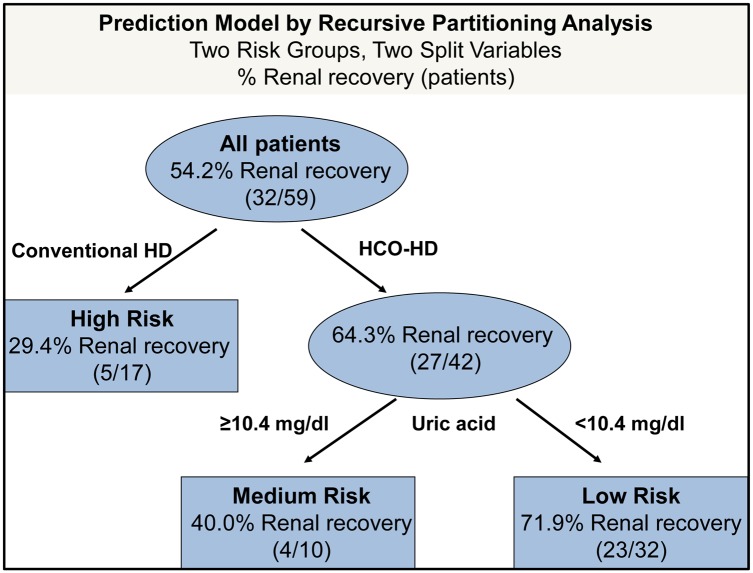
Prediction model of renal recovery by recursive partitioning analysis.Prediction model developed by recursive partitioning analysis to estimate the risk class of renal recovery based on two split variables: mode of extracorporeal therapy (HCO-HD vs. conv. HD) and serum uric acid values (<10.4 mg/dl vs. ≥10.4 mg/dl) before therapy initiation. With the application of HCO therapy, the rate of renal recovery doubled from 29% to 64% of patients. Further assessment of uric acid values predicts the probability of renal recovery more precisely, resulting in a medium-risk class (40.0% renal recovery) or low-risk class (71.9% renal recovery).